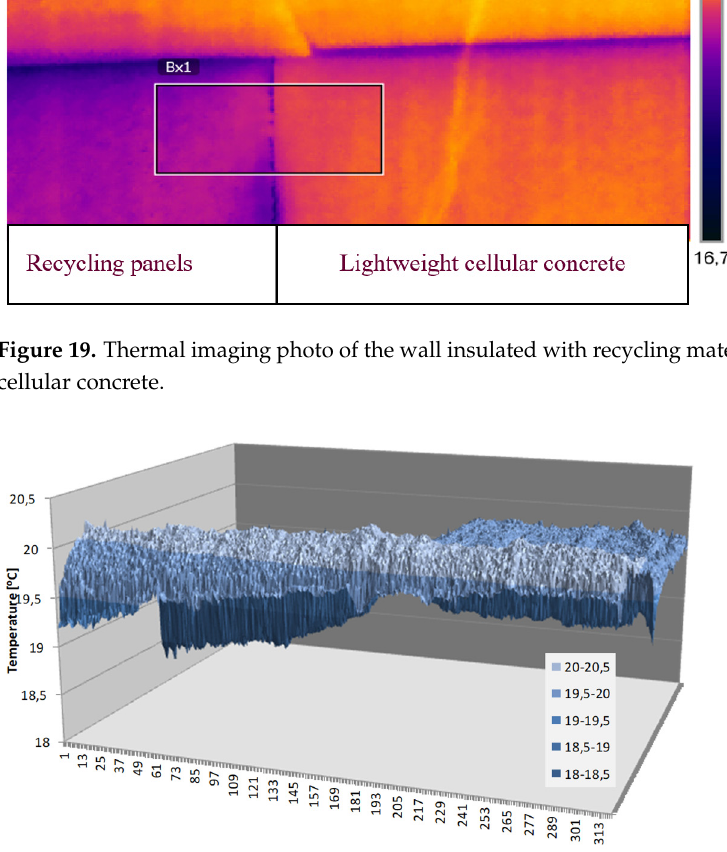
Figure 20. Temperature changes on the surface of the insulated envelope in the area B1.